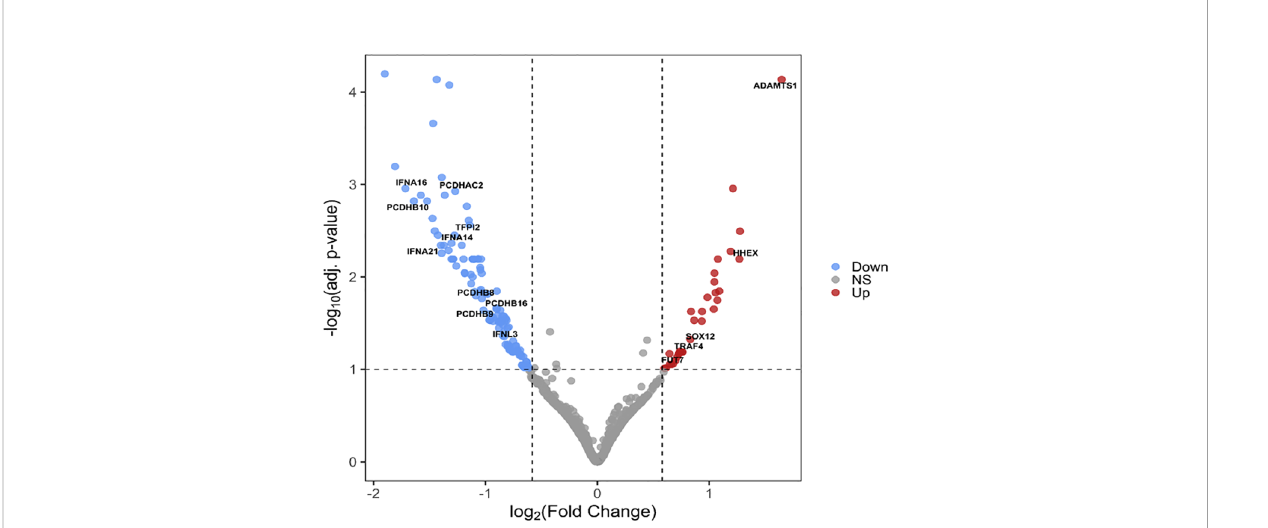
FIGURE 2 Volcano plot of DEGs between S protein expressing and mock-transfected macrophage-like cells. The -log10 adjusted p-values of the transcripts are plotted as a function of log2(fold change). Red and blue dots indicate the signi fi cantly up- and downregulated genes, respectively. Gray dots represent non-signi fi cant (NS) transcripts (p> 0.01 or LFC < 0.58 (= FC<1.5)).